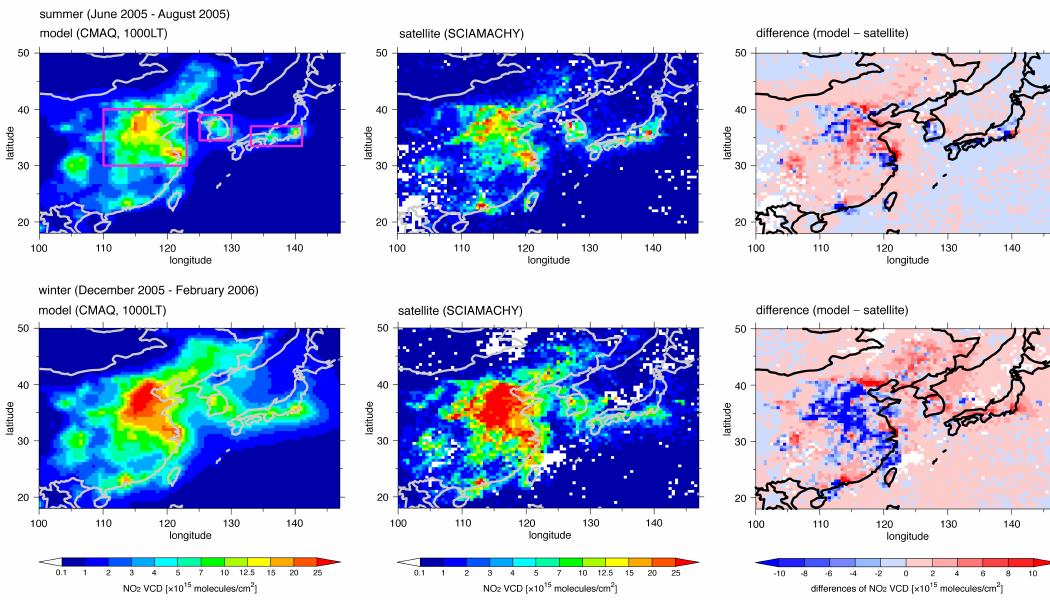
Fig. 3. Spatial distribution of tropospheric NO 2 VCD from (left) model results at 10:00LT, (center) satellite observations by SCIAMACHY, and (right) the differences between model and satellite in (top) summer (averaged between June 2005 and August 2005) and (bottom) winter (averaged between December 2005 and February 2006). The rectangular regions shown in the top-left figure are the investigated regions (central eastern China (CEC), Korea, and Japan).